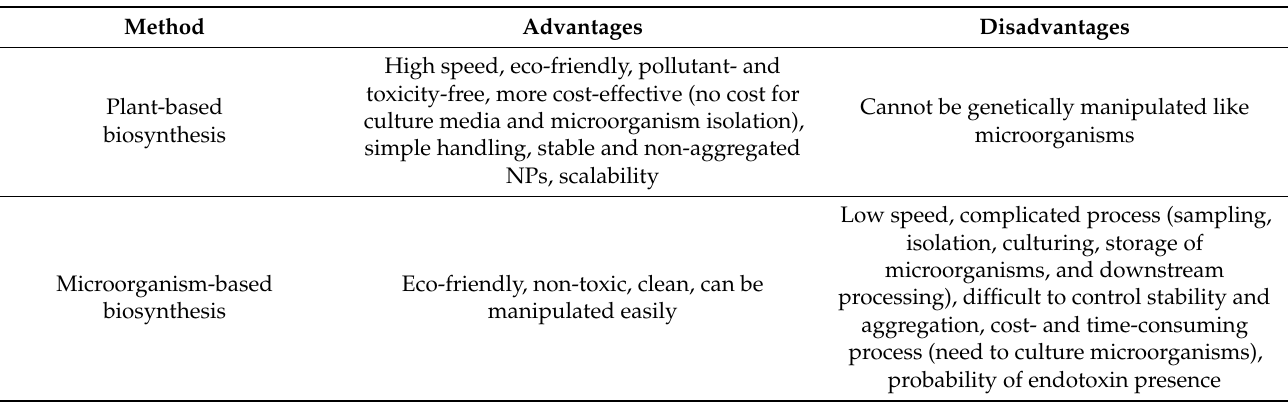
Table 1. Advantages and disadvantages of green synthesis of NPs using plant extracts and microor- ganisms.